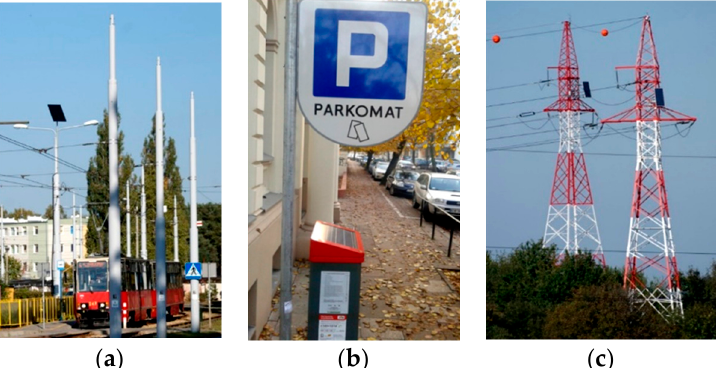
Figure 7. Examples of small PV autonomous installations. ( a ) Tramway infrastructural feature, Bydgoszcz, Glinki district. ( b ) Parking meter, Bydgoszcz, ´Sr ó dmie´scie district. ( c ) Aeronautical infrastructure feature, Bydgoszcz, Wzg ó rze Wolno´sci district. Source: own